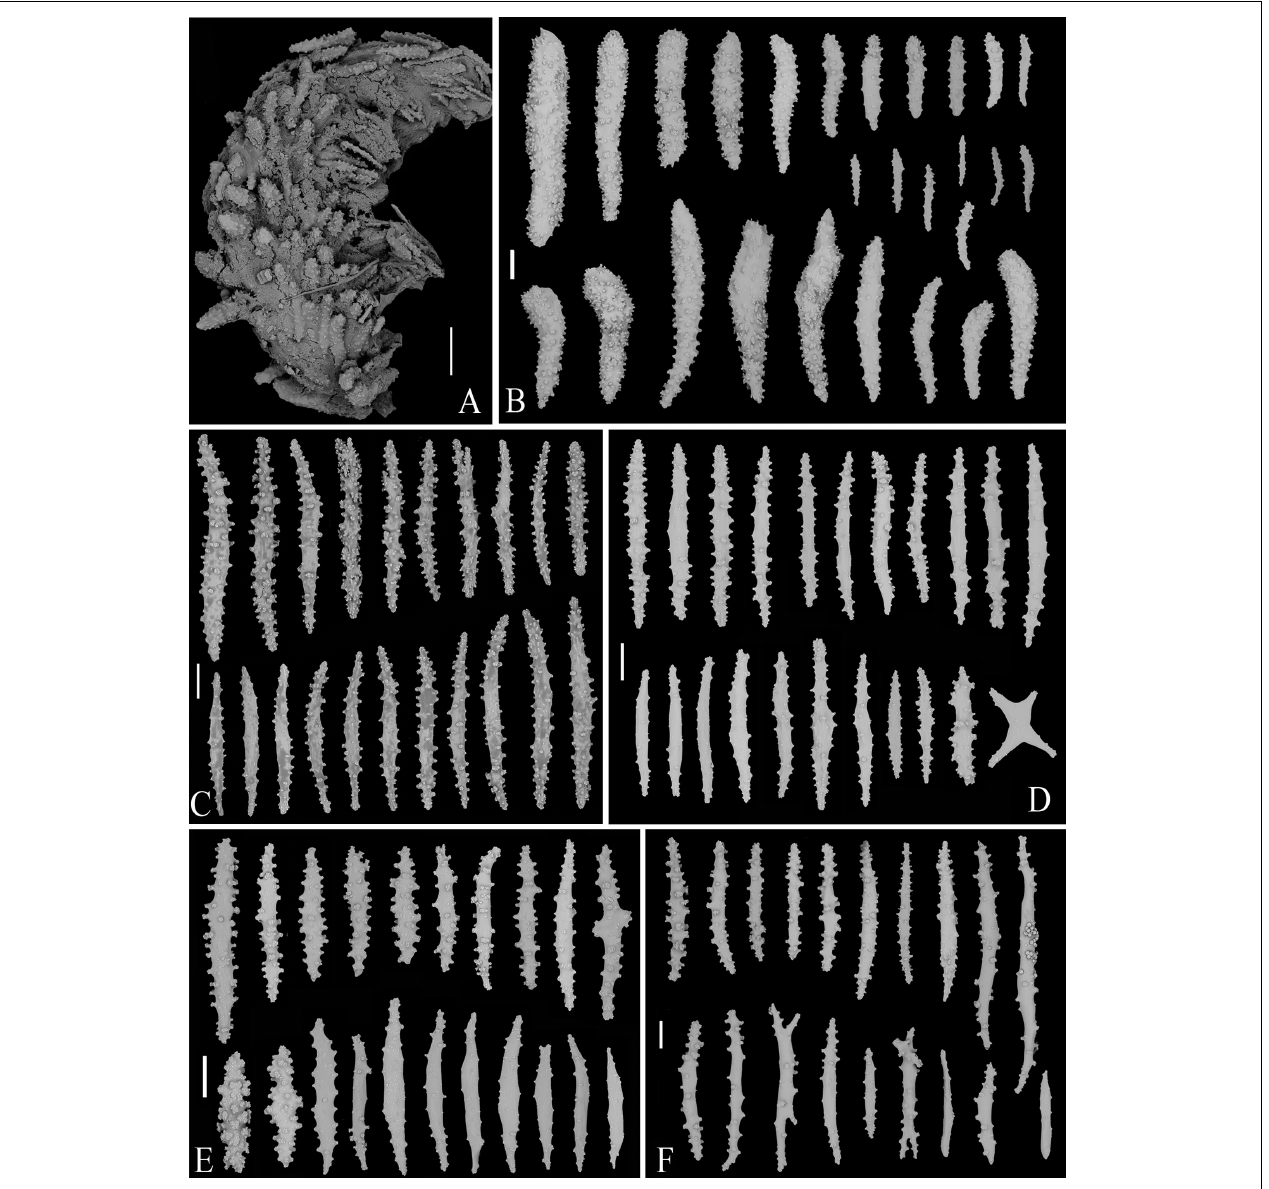
FIGURE 8 | SEM of tentacle and sclerites of Victorgorgia flabellata sp. nov. (A) A tentacle, showing arrangement of sclerites. (B) Sclerites from tentacles. (C) Sclerites from points and collarets. (D) Sclerites from calyces. (E) Sclerites from cortex. (F) Sclerites from medulla. Scale bars = 0.2 mm (A) , and 100 µ m (B–F) .